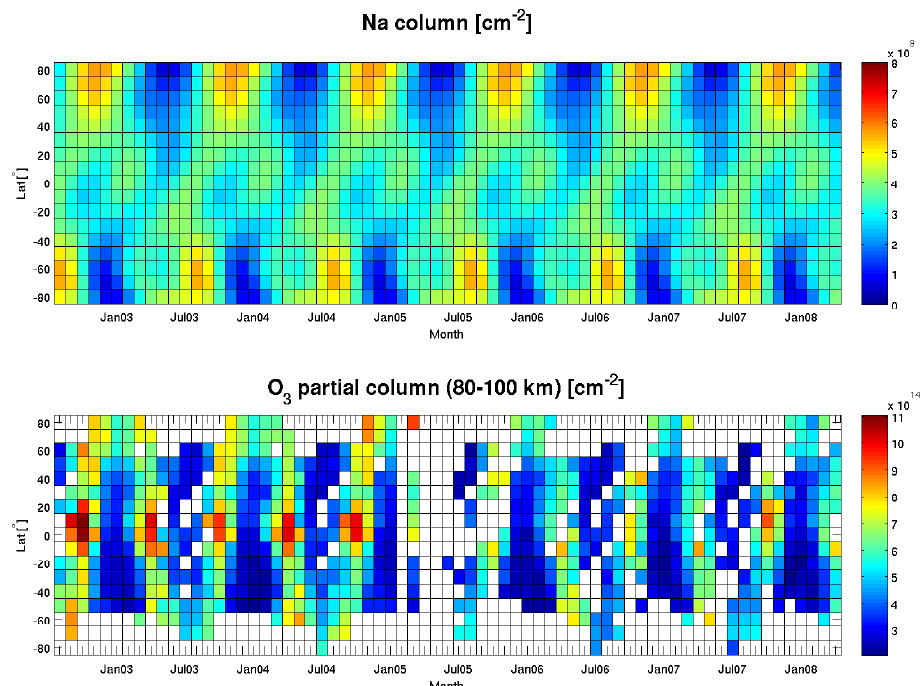
Fig. 10. Top: GOMOS sodium column climatology (as in Fig. 9). Bottom: raw GOMOS ozone partial column (between 80 and 100km). Notice the similarities between the oscillation patterns.